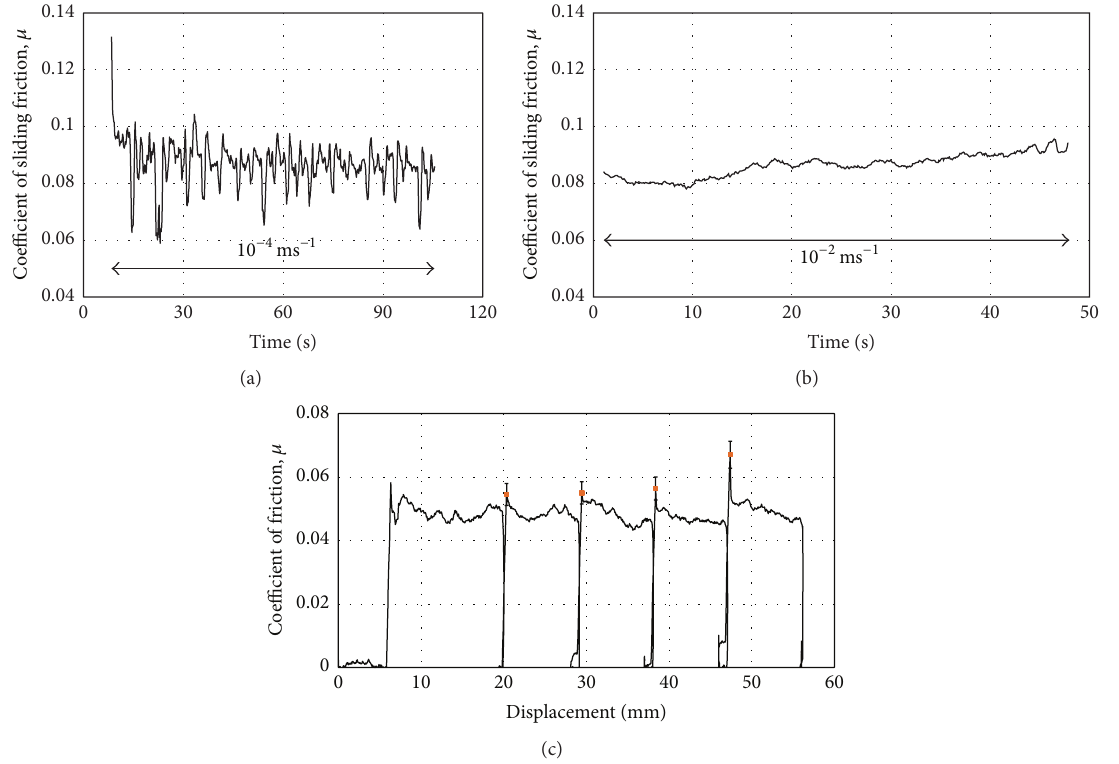
Figure 3: Example plots showing variations in the coefficient of friction. (a) Friction against time, V 𝑠 = 10 −4 ms −1 , rough aluminium at − 2 ∘ C; (b) friction against time, V 𝑠 = 10 −2 ms −1 , rough aluminium at − 2 ∘ C; (c) friction against displacement from a typical hold time test ( − 2 ∘ C, polished aluminium). Increases in static friction following periods of static contact are clear at 20, 29, 38, and 47mm of displacement and are marked on the